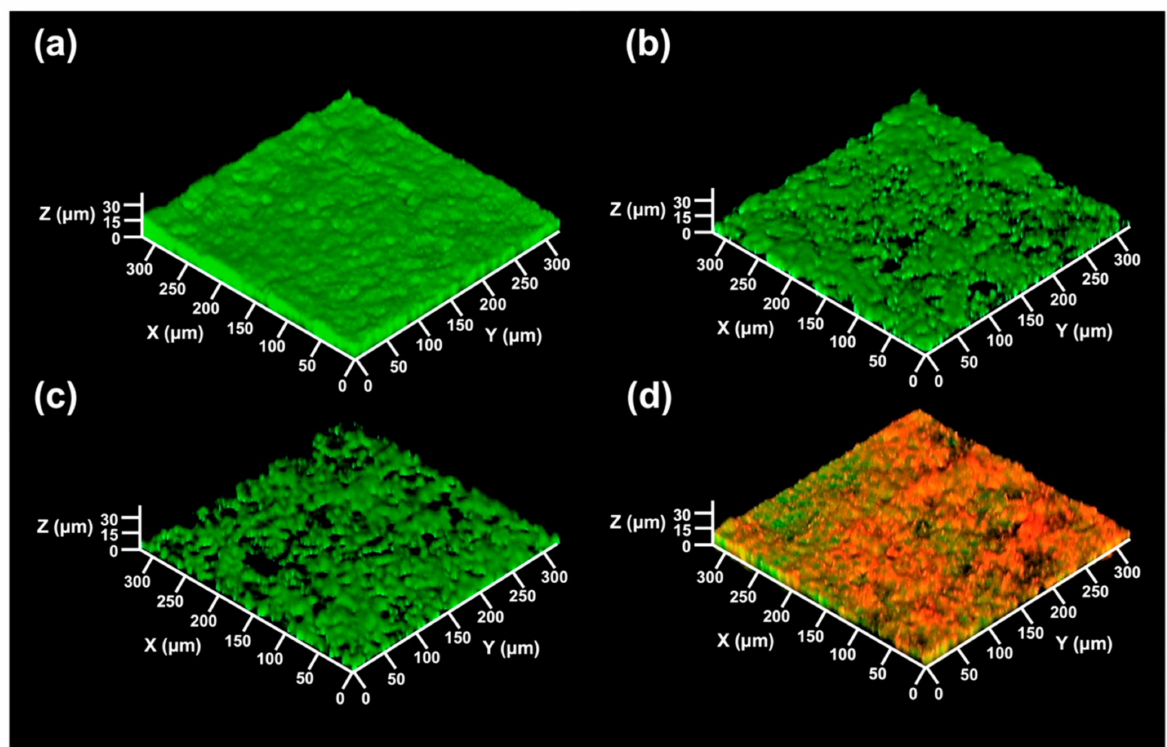
Figure 5. Presented are 3D CLSM images of the biofilm treated with varied concentrations of LAE. ( a ) The biofilm formed on the glass slide without LAE treatment. ( b – d ) The formed biofilms were treated with 0.42, 4.2, and 42 mg/L of LAE for 60 min, respectively. The green and red colors refer to the live and dead PA14 cells,